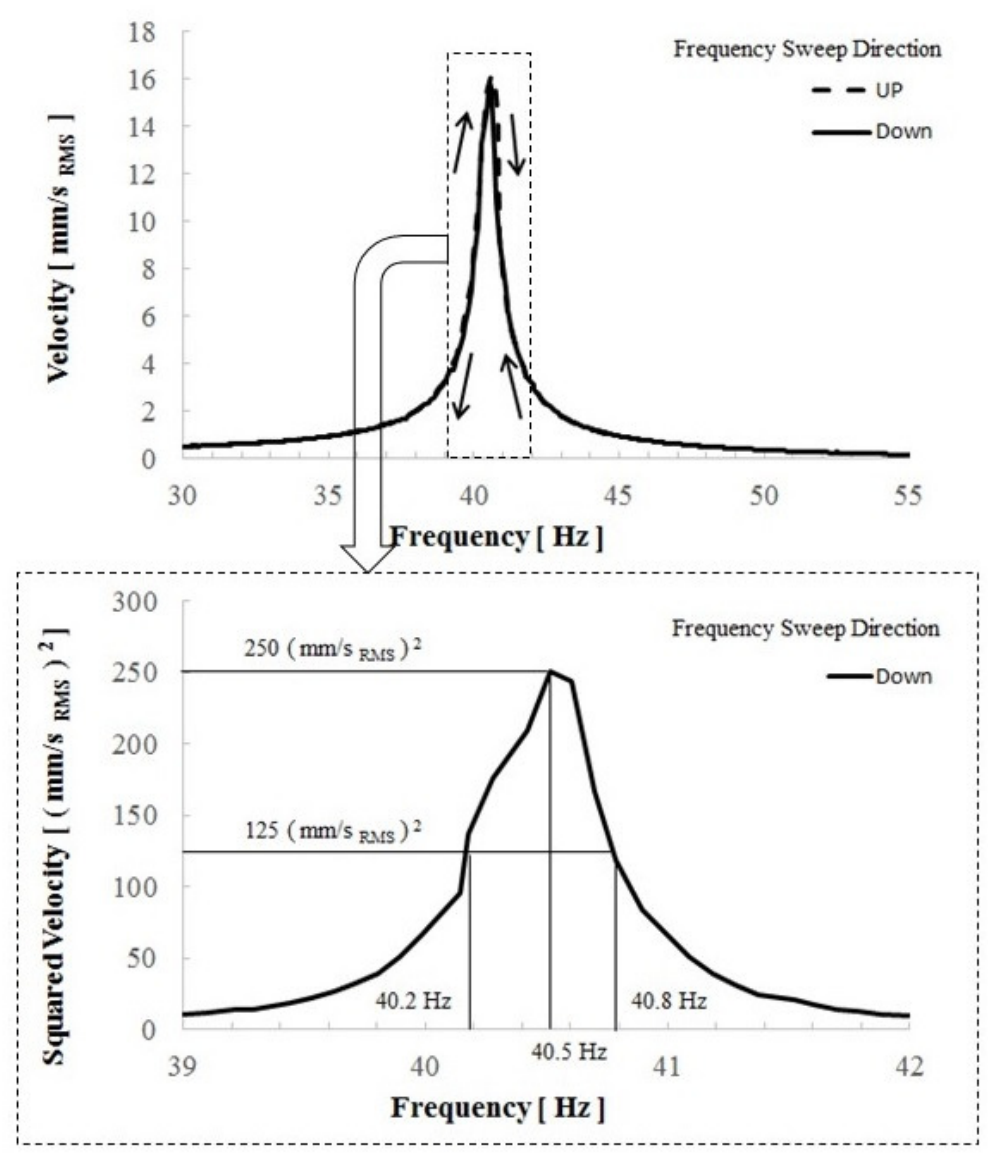
Figure 7. Observed vibration velocity as a function of the acceleration frequency under application of an external voltage in order to eliminate the electret potential via a protective resistance of 1 M Ω . The lower graph is the magnified view at a frequency from 39 to 42